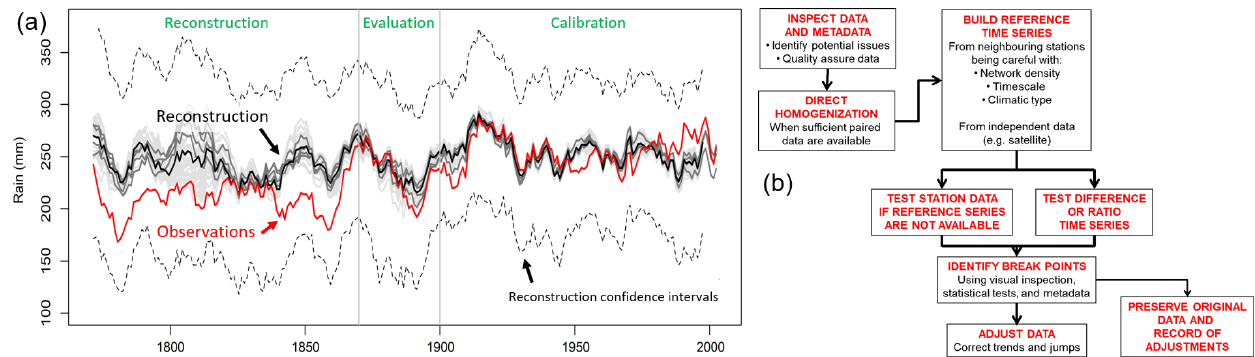
Figure 5. Homogeneity of observational records. (a) An example of spurious nonstationarity in mean observed (red line) winter precipitation for England and Wales due to inhomogeneous records. The ensemble median and individual reconstructions (black and grey lines) do not exhibit nonstationarity (from Murphy et al., 2020b). (b) An approach to data homogenization for monthly to annual climate records (adapted from Aguilar et al.,